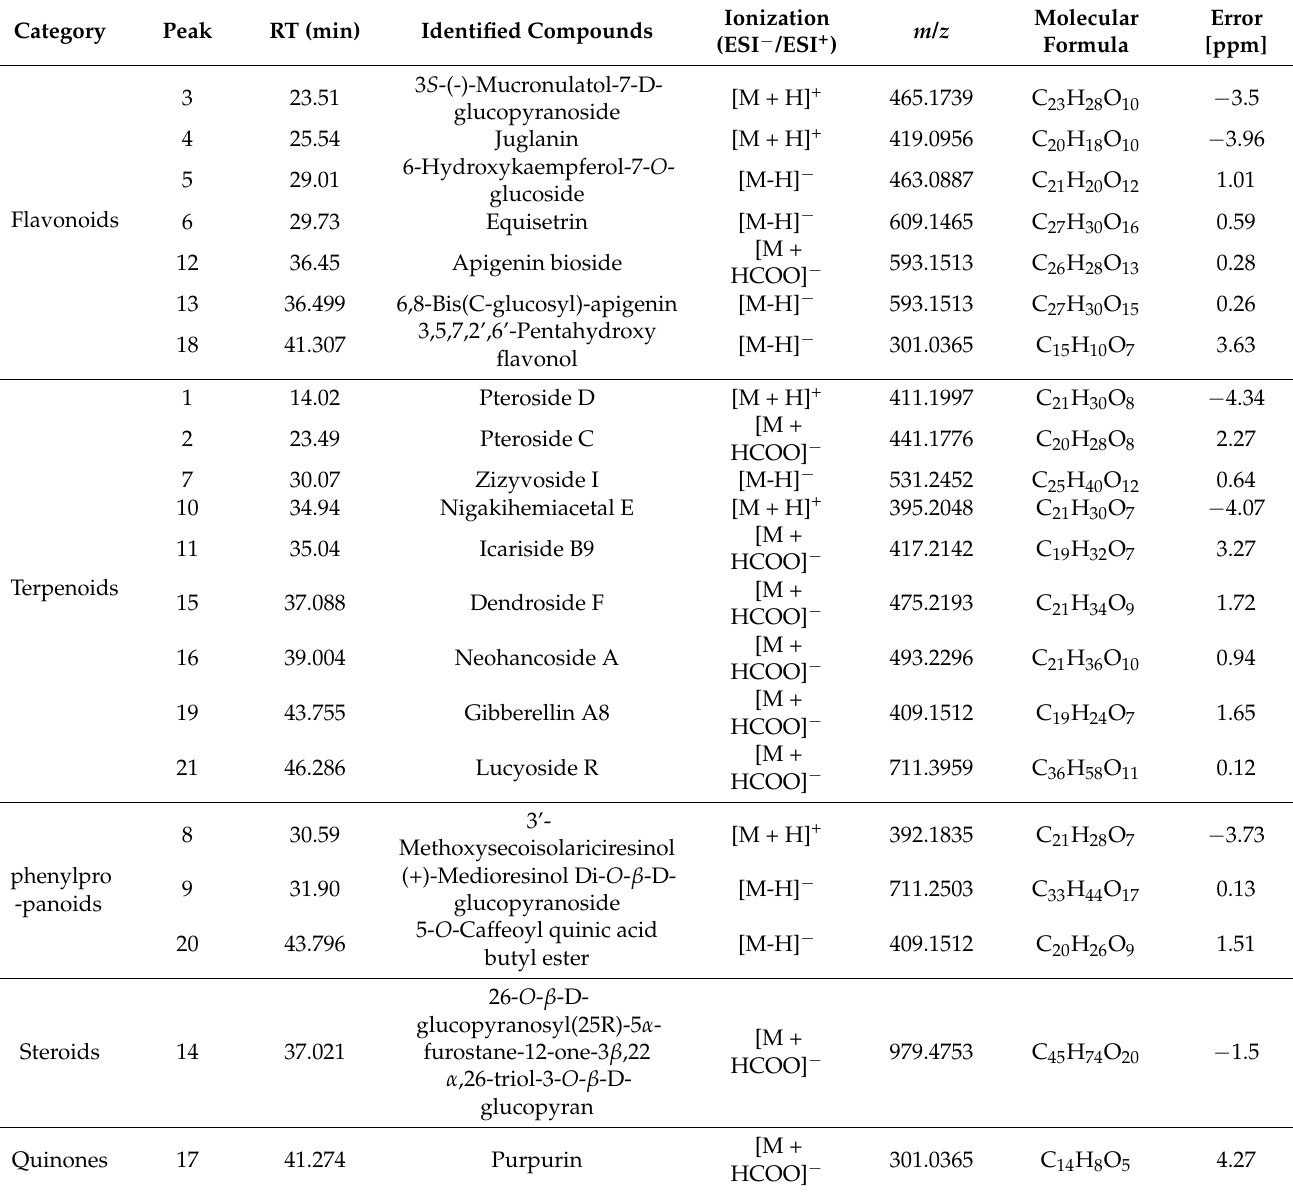
Table 1. Phytochemical compounds tentatively identified in NBF using